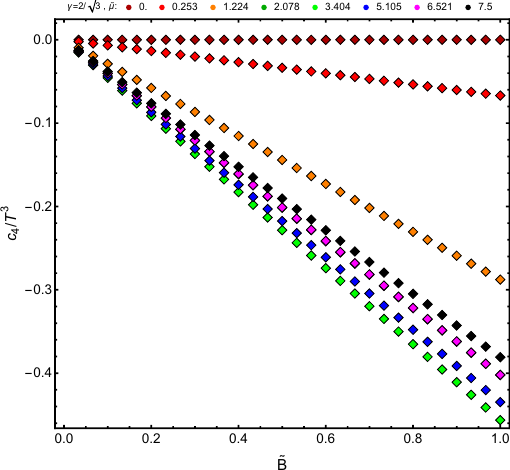
Figure 12 . The ratio of longitudinal and perpendicular conductivity σ ⊥ /σ √ fixed ˜ B for γ = 2 / 3 (left) and γ = 0 (right). Each color corresponds to a fixed value of ˜ B given by ˜ B = { 1 / 30 , 1 / 3 , 2 / 3 , 1 } (red, blue, purple, dark green).